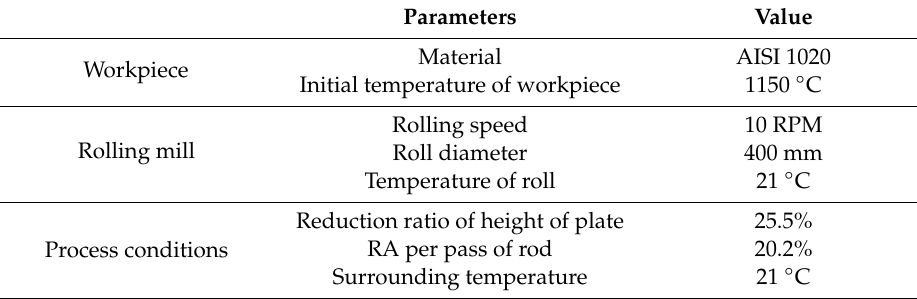
Figure 4. Schematic description showing the roll design and the measurement points of temperature using thermocouples: ( a ) cross section of flat rolling, ( b ) cross section of rod rolling, and ( c ) cross section of the longitudinal direction of the rod. Table 1. Process parameters of hot rolling test using the off-line simulator in this experiment.